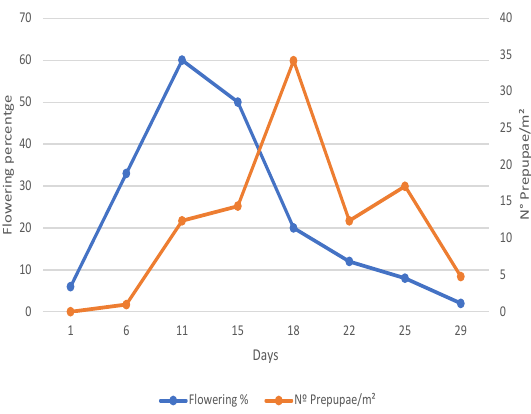
Figure 13. Flowering percentage and number of fallen Prodiplosis longifila pre-pupae per square meter.